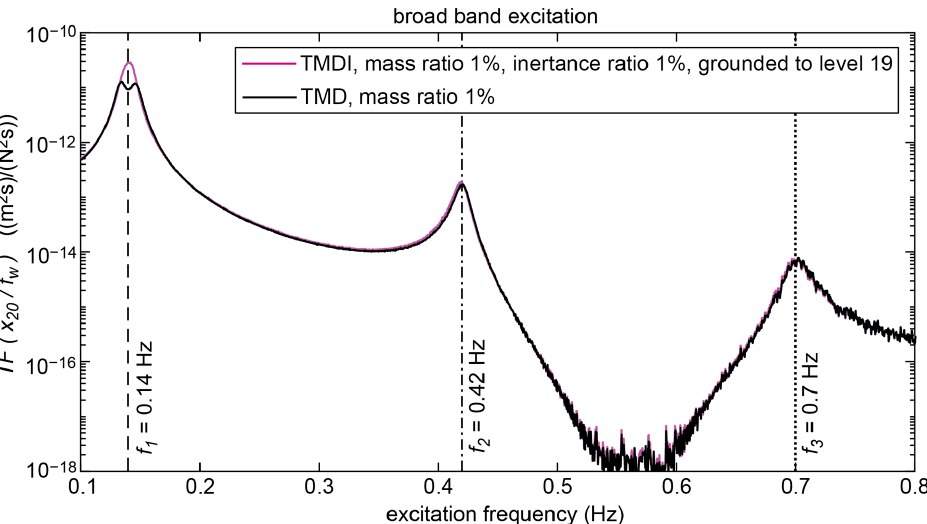
Figure 3. Transfer function between the structural displacement of level 20 and the excitation force within the frequency range of the first three bending modes. Actuators 2020 , 9 , x FOR PEER REVIEW